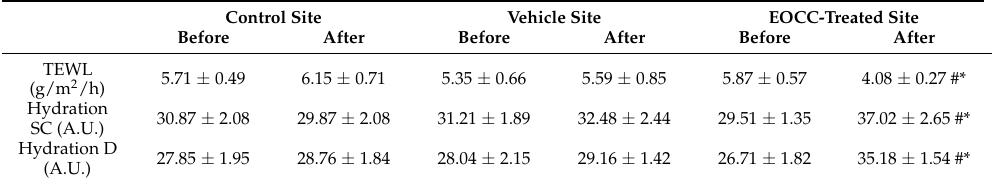
Table 2. Epidermal water balance expressed by transepidermal water loss (TEWL), stratum corneum (SC) hydration, and deep epidermis (D) hydration measured in the control site, vehicle site, and EOCC-treated site for 14 days.